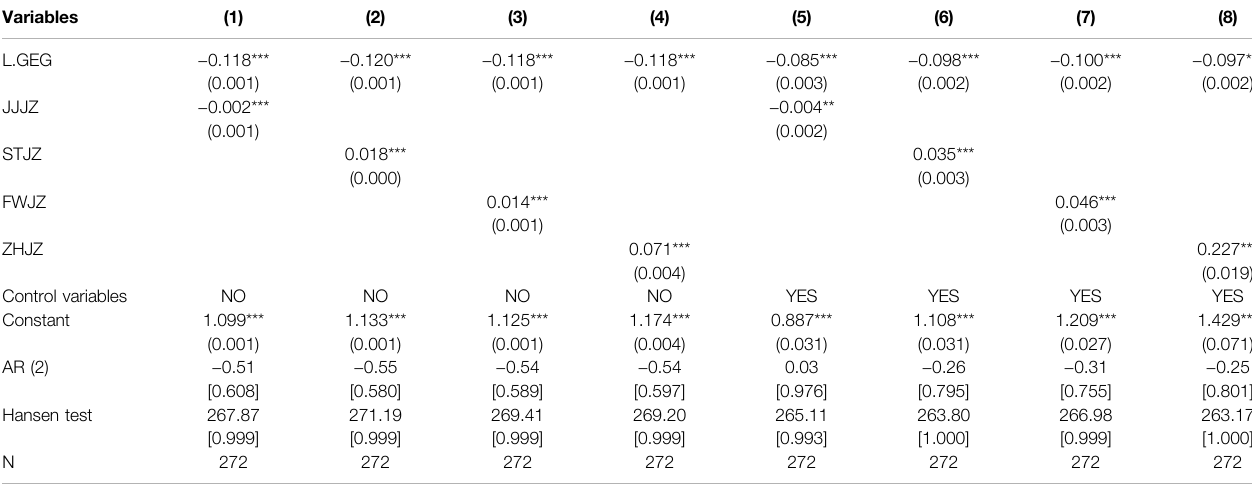
TABLE 4 | Benchmark regression results.